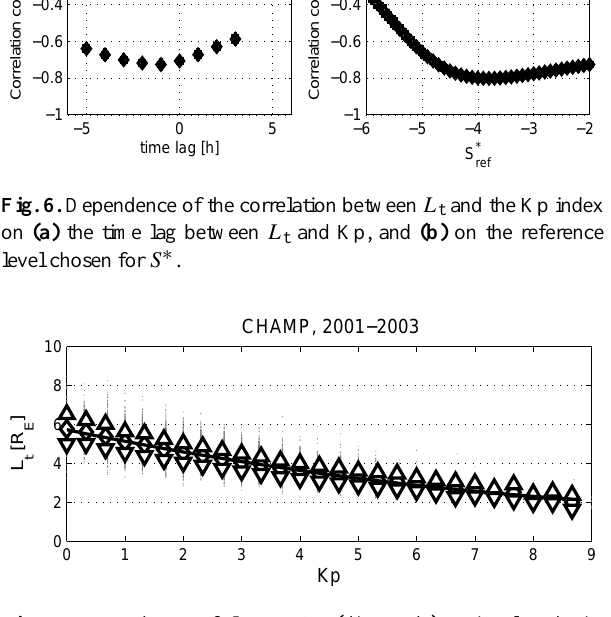
Fig. 7. Dependence of L t on Kp (diamonds). Triangles depict mean ± standard